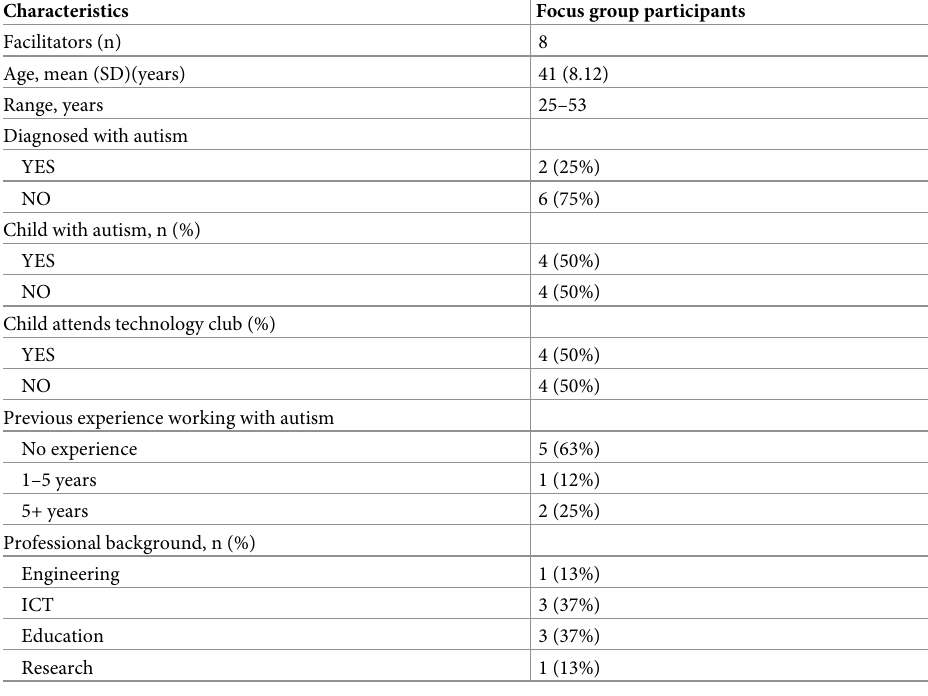
Table 4. Characteristics of facilitators who delivered computer coding classes.